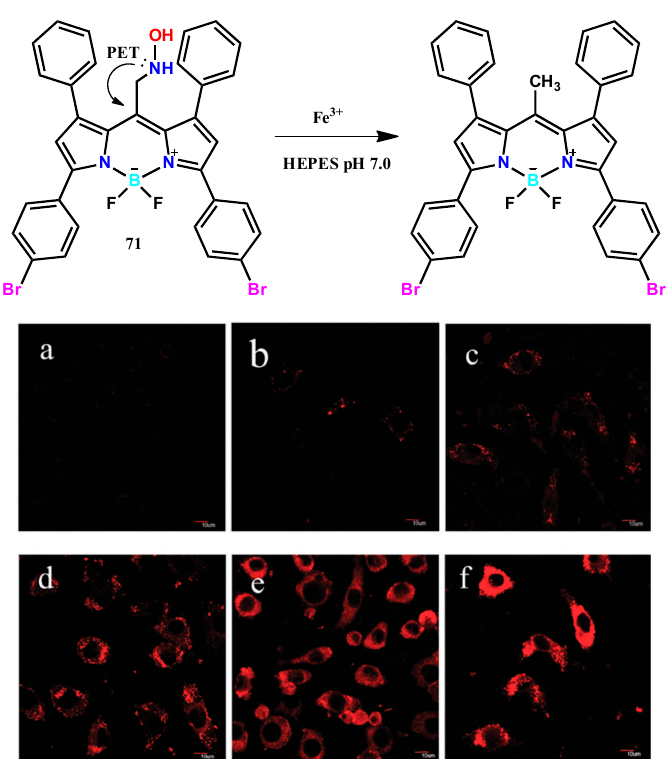
Figure 8. Confocal fluorescence images of living MCF-7 cells incubated with various concentrations of Fe 3+ . MCF-7 cells loaded with 71 and Fe 3+ for 15 min of ( a ) Control, ( b ) 0.01 mM, ( c ) 0.1 mM, ( d ) 1 mM, ( e ) 10 mM, and ( f ) 100 mM. Scale bar is 10 mm (Reproduced from Ref. [80] with permission from The Royal Society of Chemistry). Molecules 2019 , 24 , x